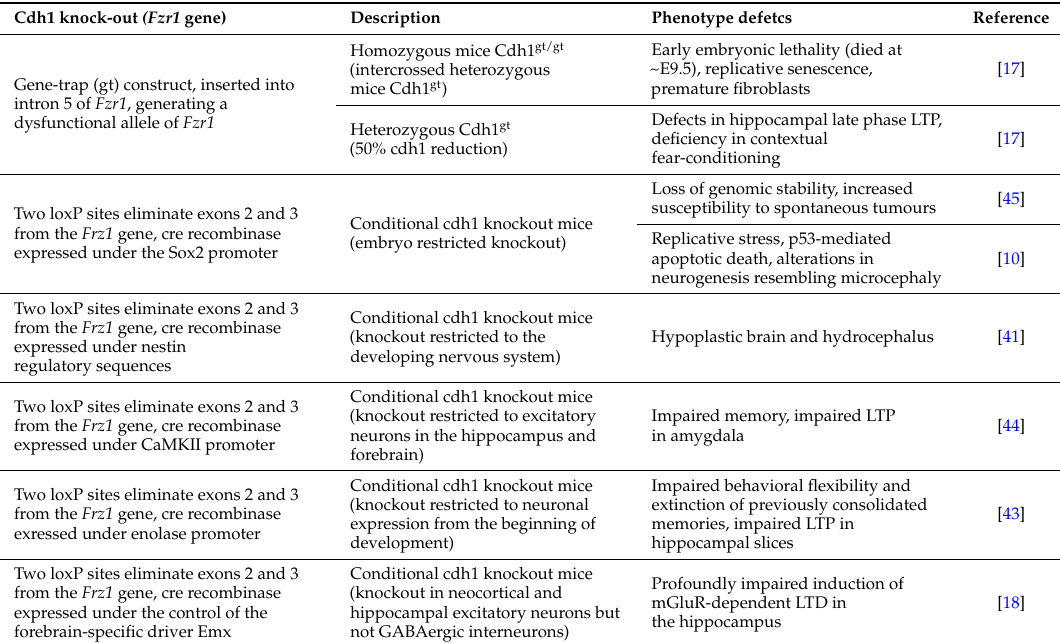
Table 2. Summary of cdh1 knockout mouse models and their phenotype. Several impaired functions related to the nervous system have been observed in various cdh1 knockout mouse models.